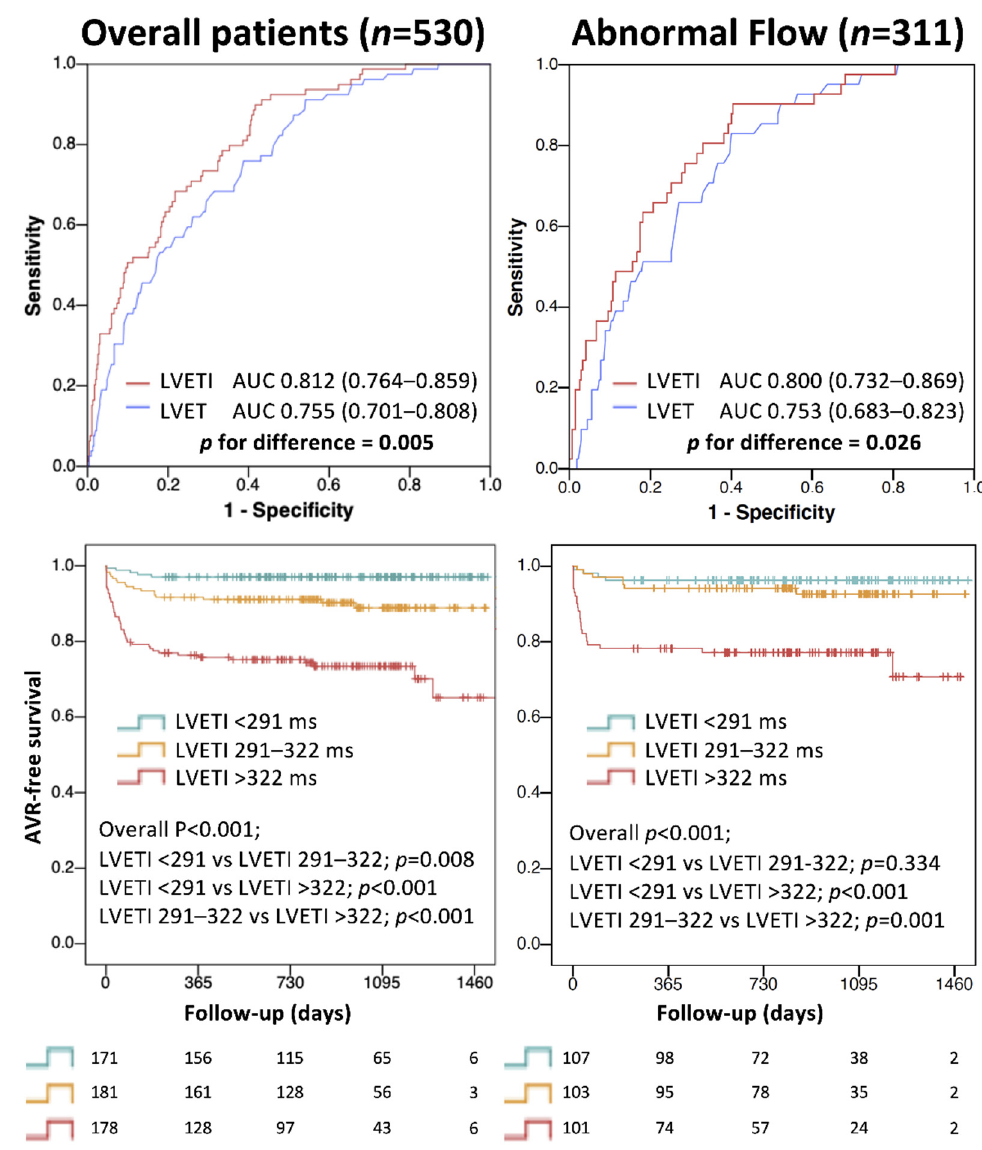
Figure 6. Upper: receiver operating characteristic curves representing the accuracy of left ventricular ejection time (LVET) and LVET index (LVETI) in detecting severe aortic stenosis in overall patients ( upper left ) and in the abnormal flow subgroup ( upper right ). Lower: freedom from aortic valve replacement (AVR) according to tertiles of LVETI in overall patients ( lower left ) and in the abnormal flow subgroup ( lower right ). AUC, area under the curve.